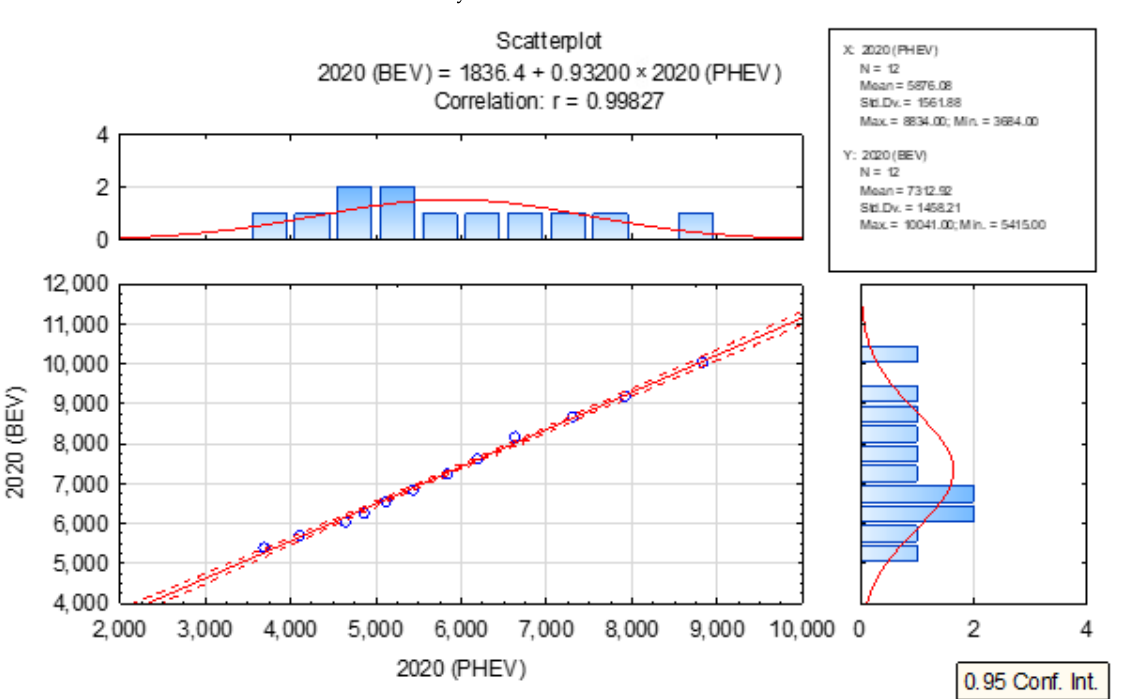
Figure 7. Scatterplot—linear correlation between the number of BEV and PHEV vehicles on the market in Poland in 2020.